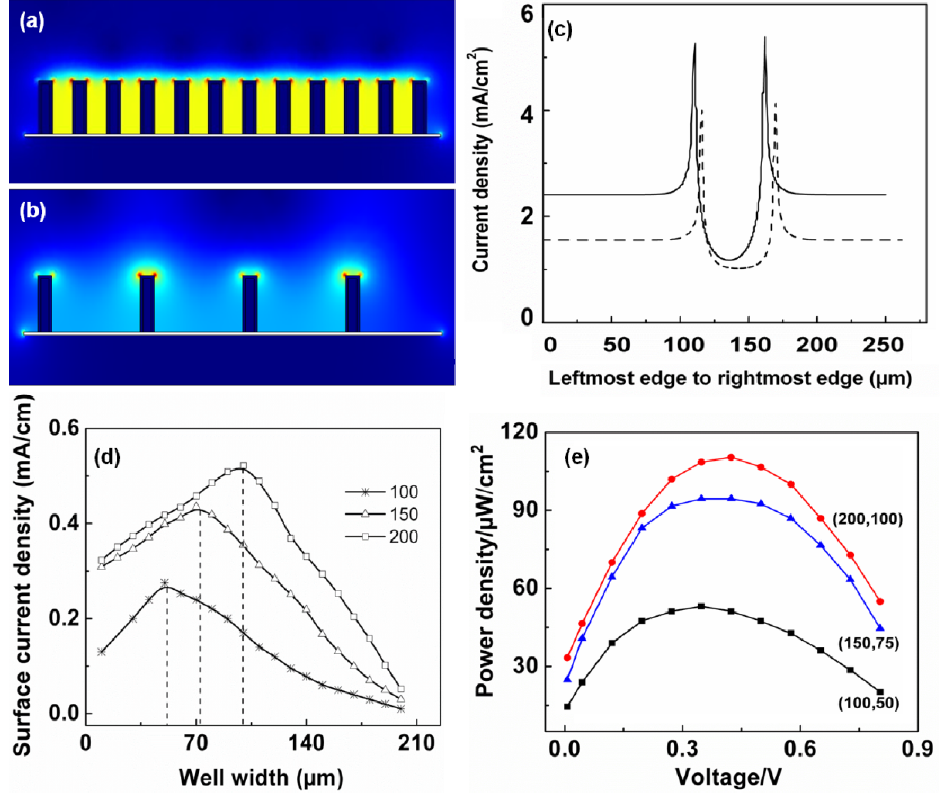
Figure 5. ( a , b ) Current density profile for one row of microelectrodes at 100 µm with different well width 50 µm and 100 µm; ( c ) current density at the surface of electrode along the vertical direction inside the well: 50 µm (dash line); 100 µm (solid line); ( d ) change of line current density with respect to electrode height and well width; ( e ) power density vs. cell voltage at different electrode heights. The height to well width ratio of electrode is